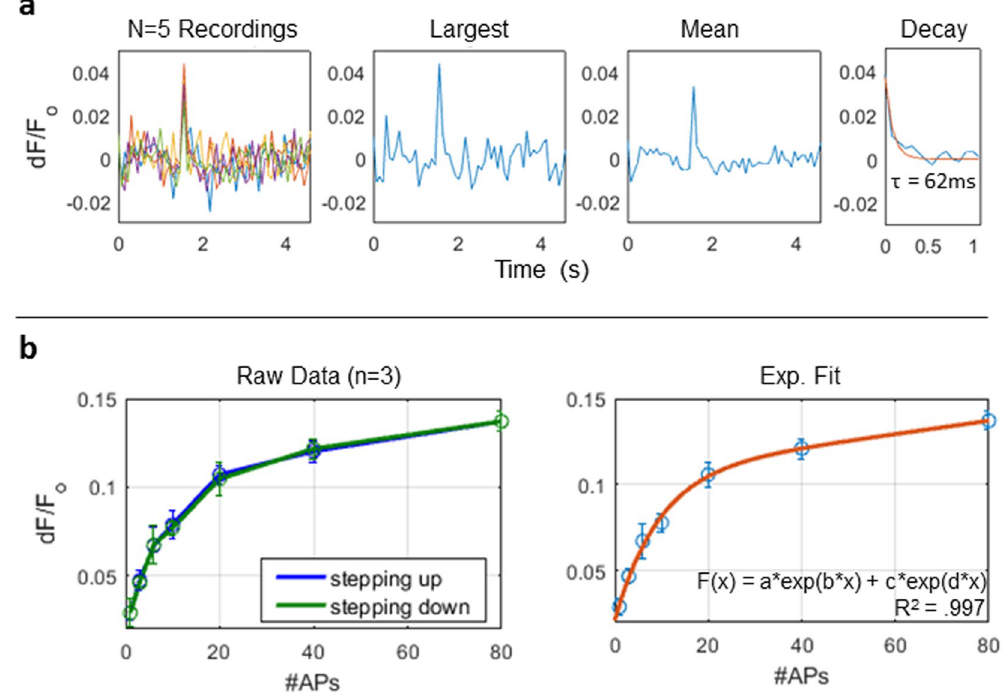
Figure 2. Calcium response to a single action potential and short bursts of action potentials. ( a ) Fluorescence response to a single action potential at a node of Ranvier, showing from left to right: five raw recordings, largest amplitude response trace, mean signal, and mean signal decay with exponential fit. ( b ) Mean fluorescence amplitude change with increasing number of action potentials in a stimulus train: a 100 Hz pulse train was applied for increasing durations to include more action potentials (1–80 APs). The signal amplitude begins to plateau as it reaches a relative steady state. Panel (left) shows mean amplitude measurements for three nodes acquired as the number of action potentials is ramped ‘up’ as well as ‘down’, showing no hysteresis. Panel (right): mean amplitude measurements are well fit by a double exponential function (R 2